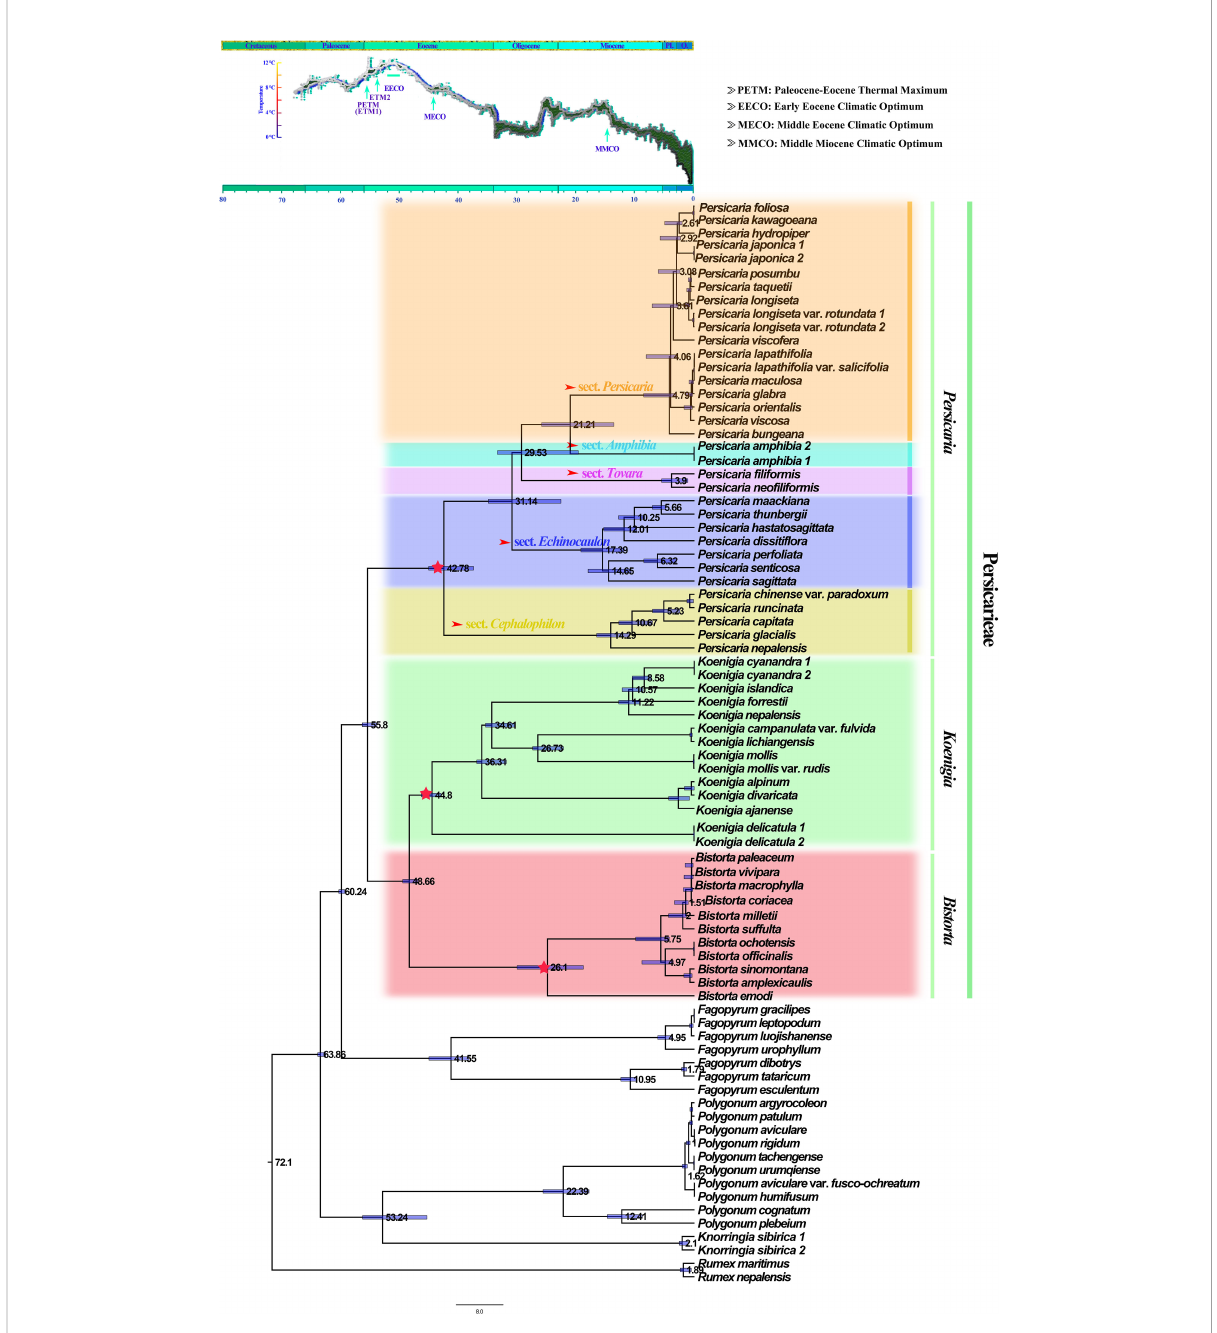
FIGURE 4 Chronogram of Persicarieae obtained with TreePL. Blue bars span from the minimum to the maximum estimates of the age of each internal node. The number at the node represents the age of the clade. The three pentagrams represent the divergence times of the three genera in Persicarieae. The fi ve arrows point to the divergence times of the fi ve sections within Persicaria . The chronogram used a deep-sea benthic foraminiferal oxygen-isotope curve as modi fi ed by Zachos et al. (2019), showing the evolution of global climate over the last 70 Ma. The ages of stratigraphic boundaries are from the International Chronostratigraphic Map (Pl., Pliocene; Q,